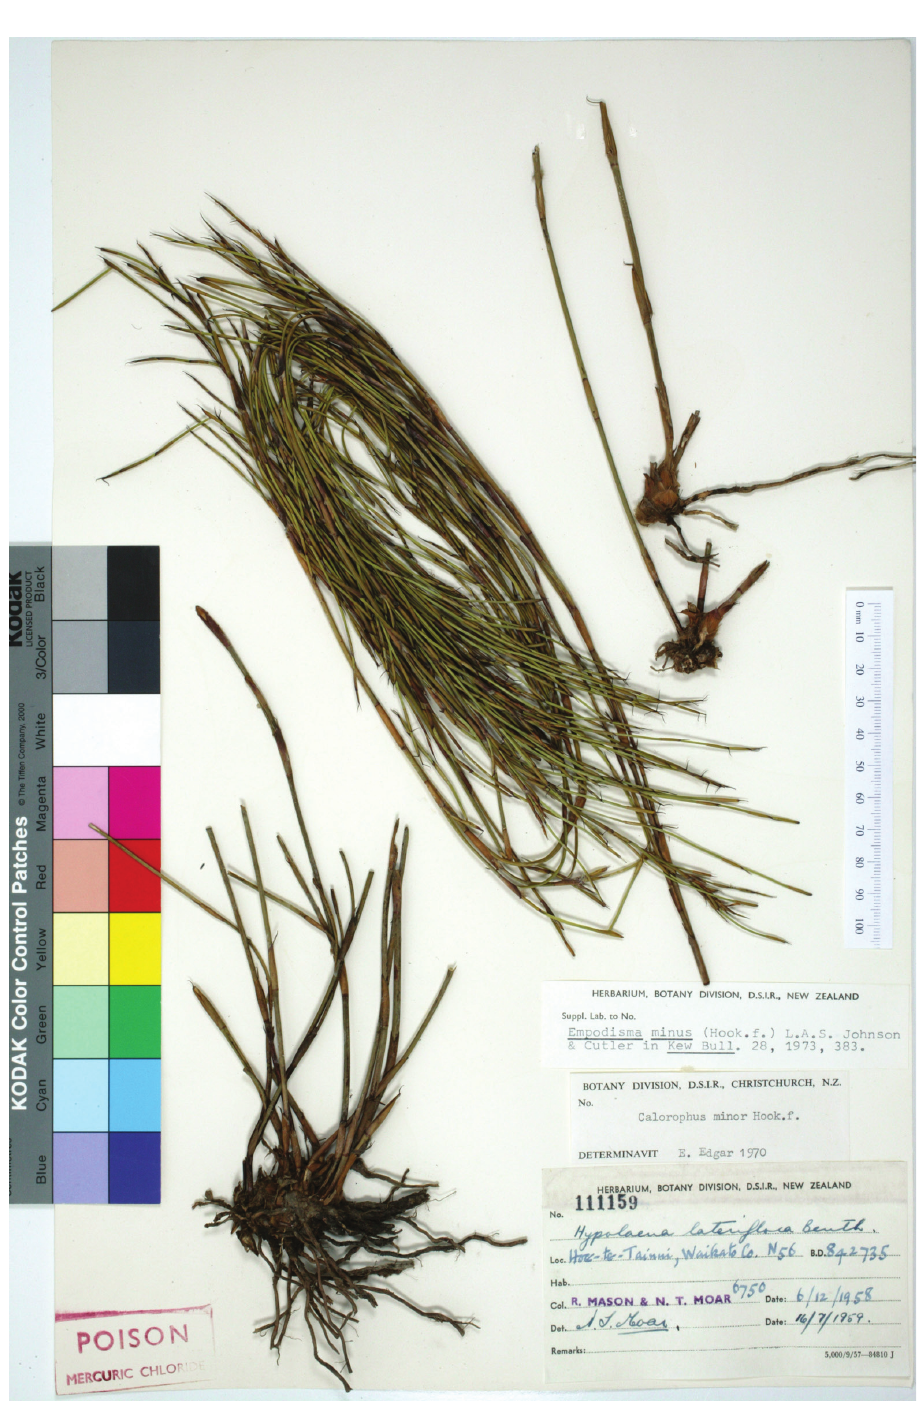
Figure 8. Type of Empodisma robustum, N56 R. Mason, N.T. Moar 6750, 6/12/1958,